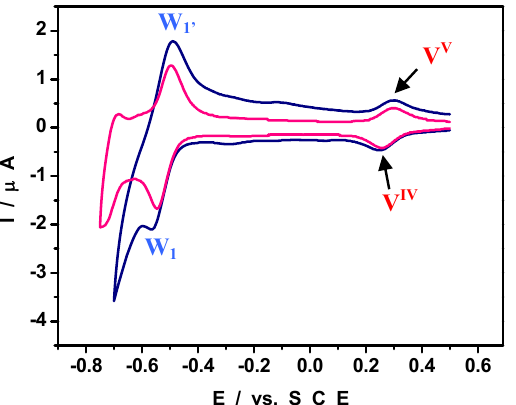
Figure 4. Cyclic voltammograms run in a pH = 5 medium with two differently modified glassy carbon electrodes (GC): pink curve: HPV directly adsorbed; navy curve: Pd 0 @POM film issued from the supernatant solution collected during the mother solution